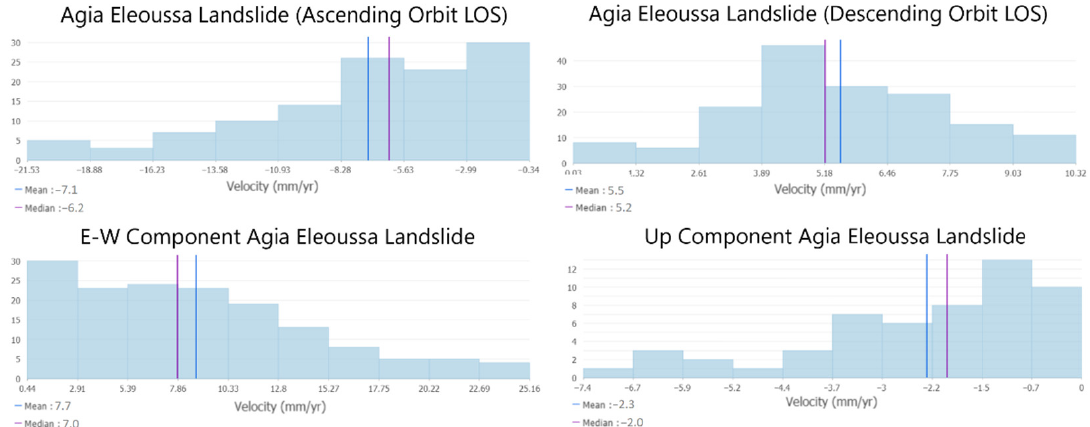
Figure 8. Histograms of LOS/E-W/U-D velocities of active landslides in the Agia Eleoussa area (Af- fected area: 1,600,000 m 2 ).